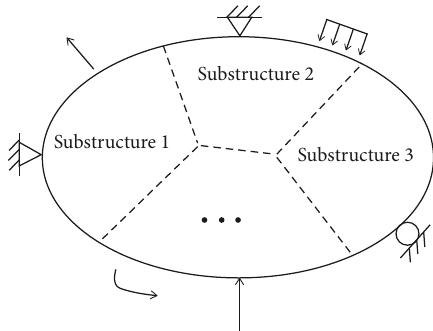
Figure 5: Substructuring of an entire